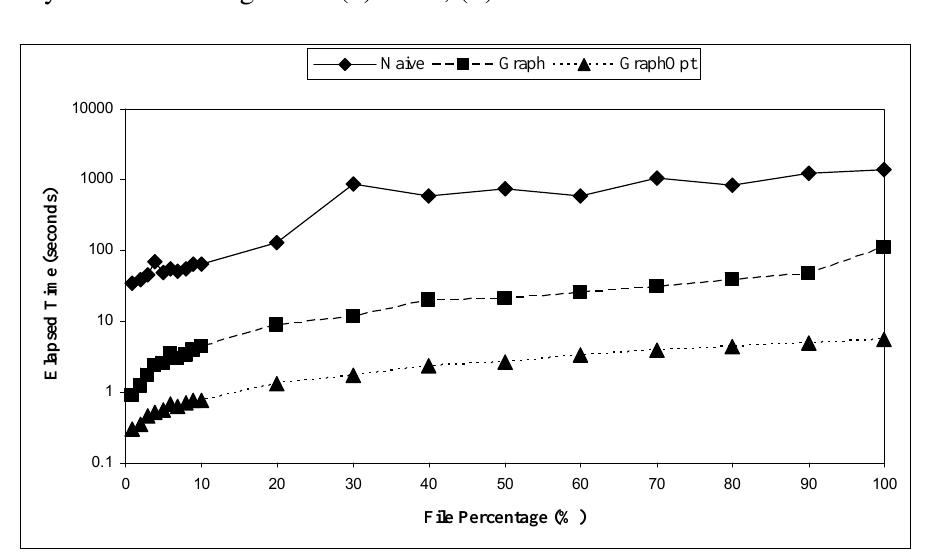
Figure 14. Elapsed times of Naive , Graph , and GraphOpt algorithms for WL1 and WL2 , respectively. Y axis is in log scale. ( a ) WL1; ( b )